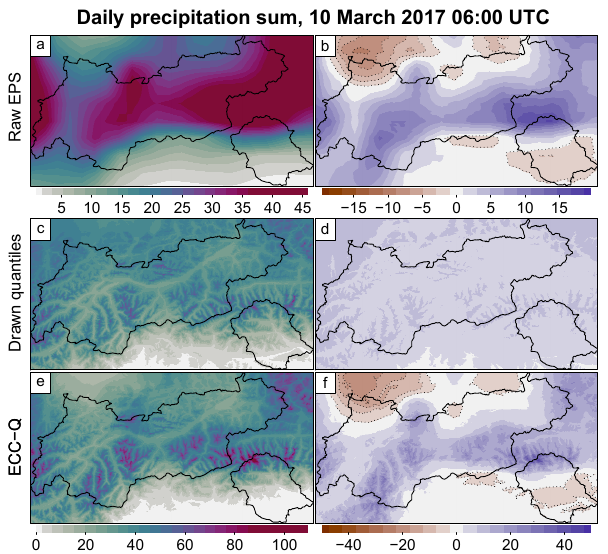
Figure 4. 2m temperature forecasts of member 38 for 10 March 2017 00:00UTC. Top–down: raw EPS (a, b) , unsorted quan- tile (c, d) , and ECC-Q (e, f) after restoring the rank order structure. Forecast ( a, c, e ; ◦ C) and deviation of this forecast from the median of the corresponding ensemble ( b, d, f ; ◦ C) are shown. Overlays: contours for positive deviation (dashed) and the borders of the gov- ernmental area of Tyrol (solid). Please note that the color scale of the top row differs from the scale of the two lower rows.